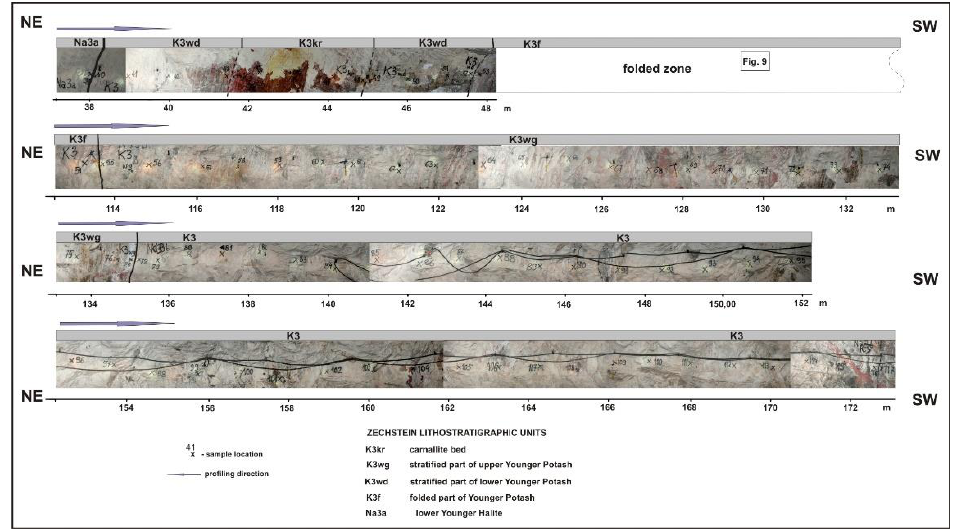
Figure 10. Sampled profile Z-3/2 of K3 in a gallery of salt mine KŁODAWA S.A., mine level 600 m, Kłodawa salt dome.Location of Fig. 9 was indicated in profile.